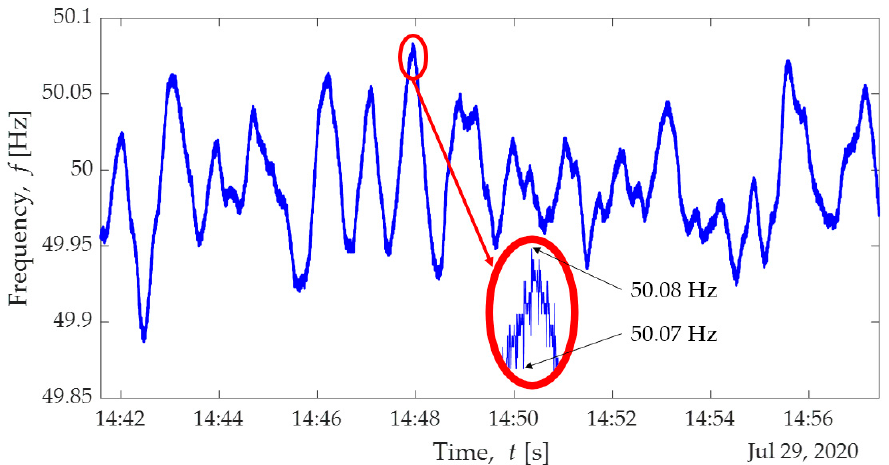
Figure 18. Time-series of electrical frequency of the Nordic Power system at Porsgrunn Norway recorded using an Arbiter TM Systems 1133A Power Sentinel TM 29 July 2020 ( f sampling = 25 Hz, 25 sam- ples per second).